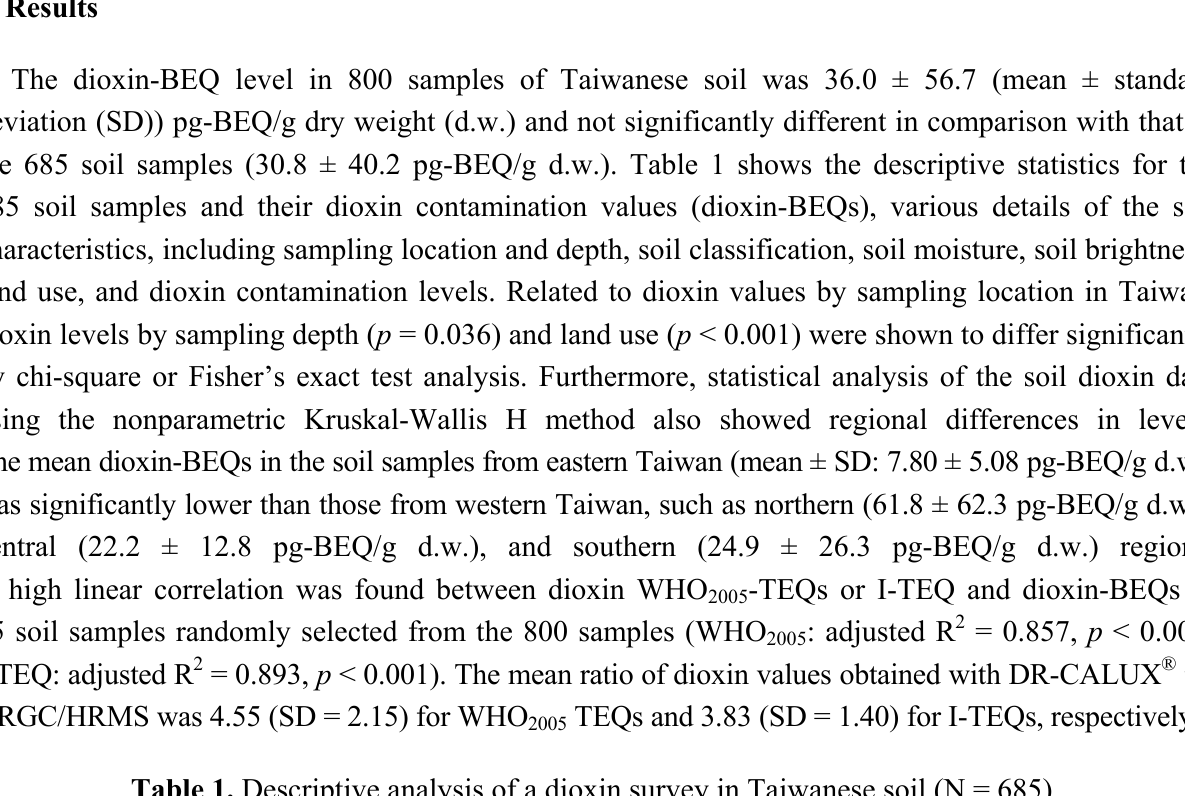
Table 1. Descriptive analysis of a dioxin survey in Taiwanese soil (N =